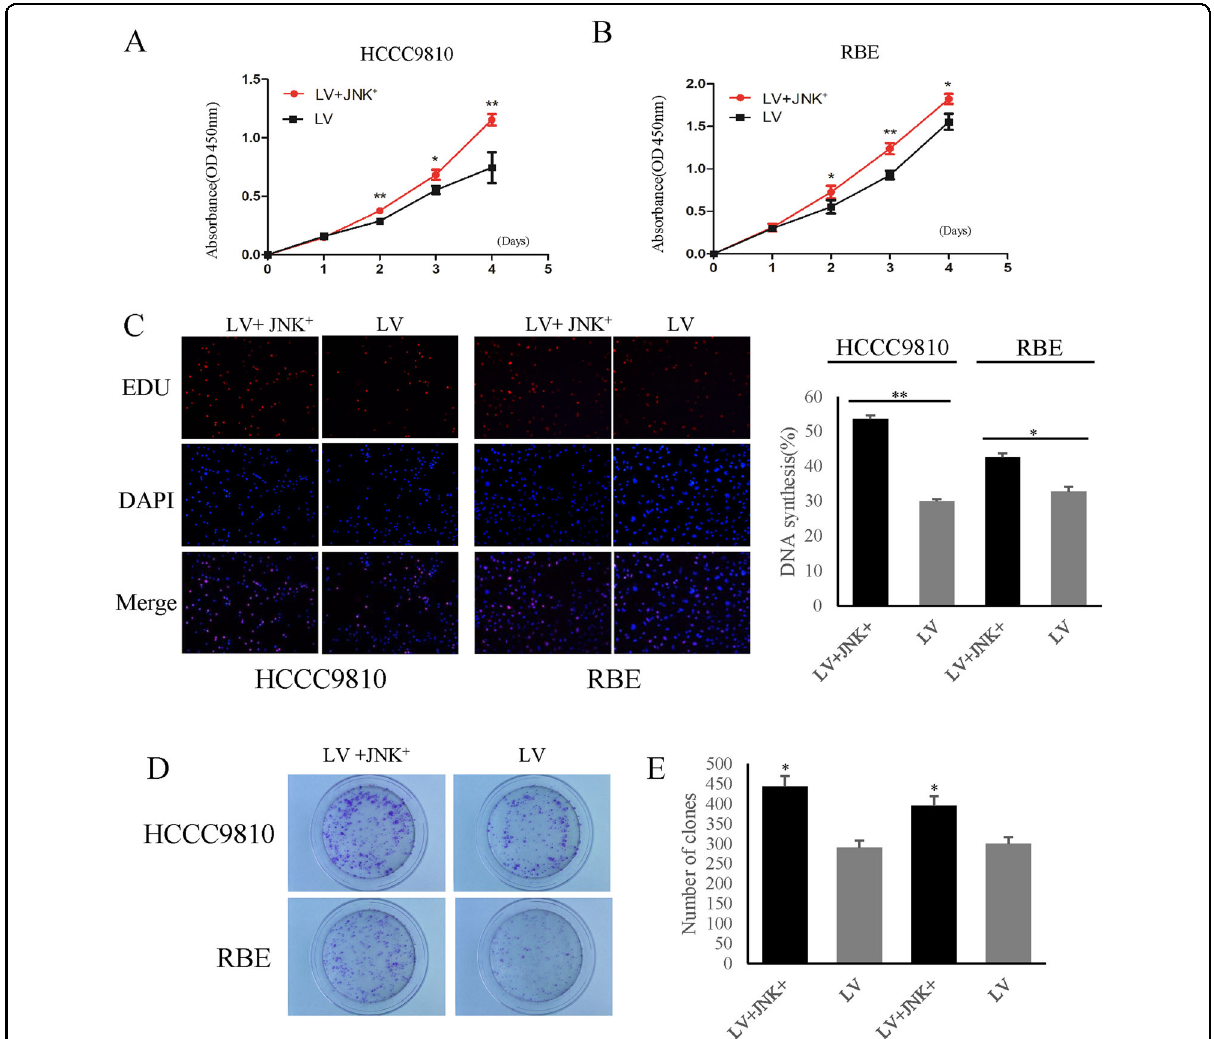
Fig. 5 BUB1B regulated proliferation of CAA cells in a JNK-c-Jun-dependent manner. A , B CCA cell proliferation was detected by the MTT cell proliferation assay. The activation of JNK-c-Jun could largely rescue the inhibitory effect of knockdown BUB1B on proliferation in both HCCC9810 and RBE cells. C CCA cell proliferation was detected by EdU staining. D , E Representative images of colony formation assays and colony counts. The colony number and size were higher in the JNK-c-Jun activation group compared to the control group (* p < 0.05; ** p <